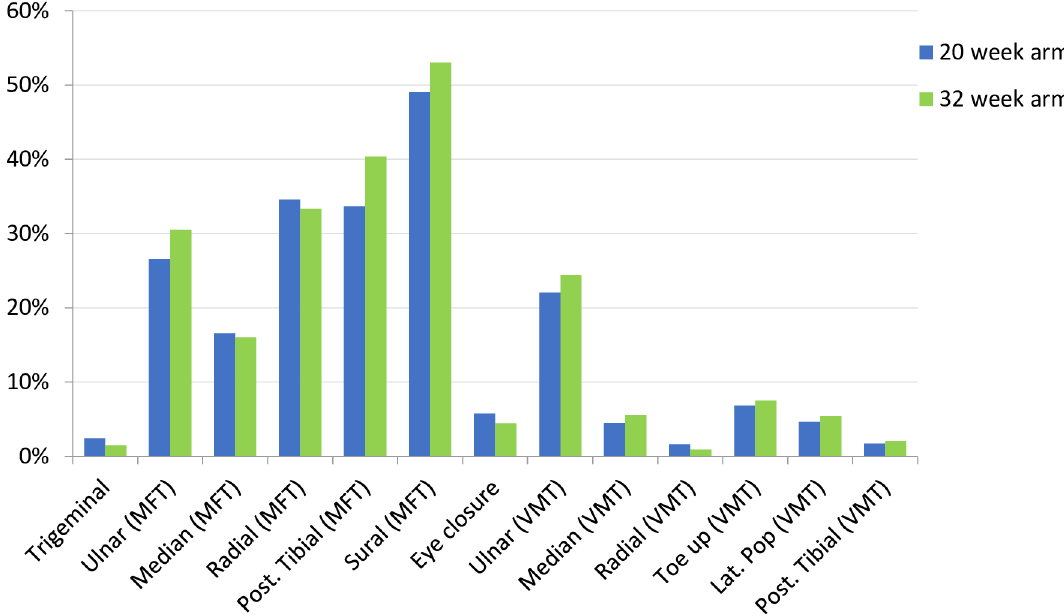
Fig 2. Baseline impairments for sensory and motor nerves.